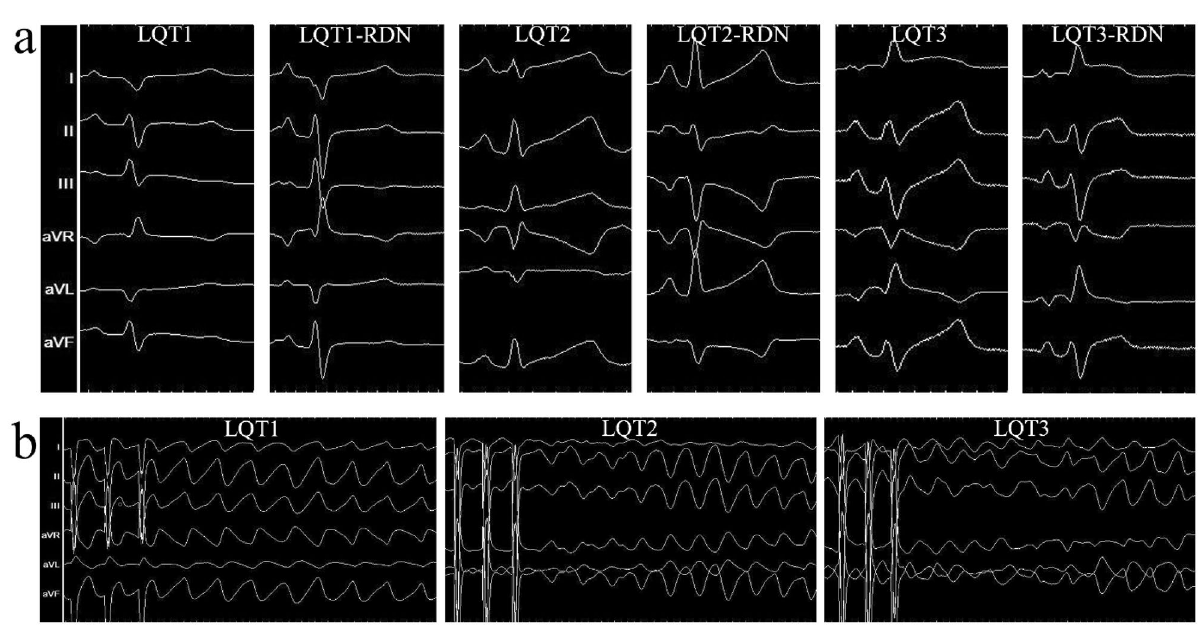
Figure 1. ( a ) Representative examples of ECG under the final LQTS induction dose in all groups. ( b ) Representative examples of ECG of inducible VAs in the LQT1, LQT2, and LQT3